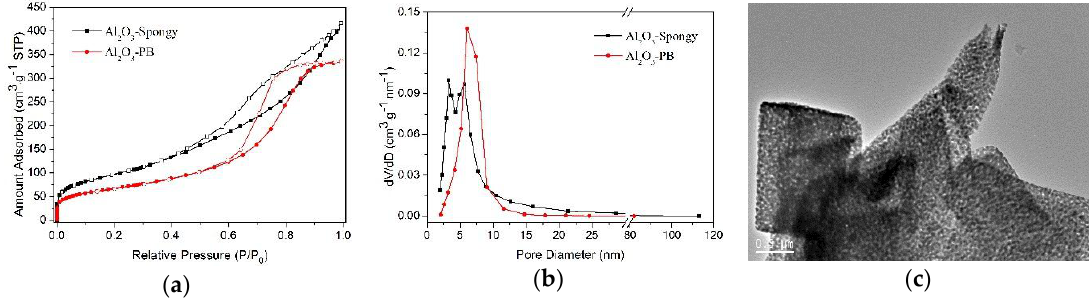
Figure 3. ( a ) N 2 adsorption-desorption isotherms and ( b ) pore size distribution of Al 2 O 3 -Spongy and Al 2 O 3 -PB, ( c ) TEM images of commercial alumina Al 2 O 3 -PB. Table 2. Textural properties of the obtained alumina samples.